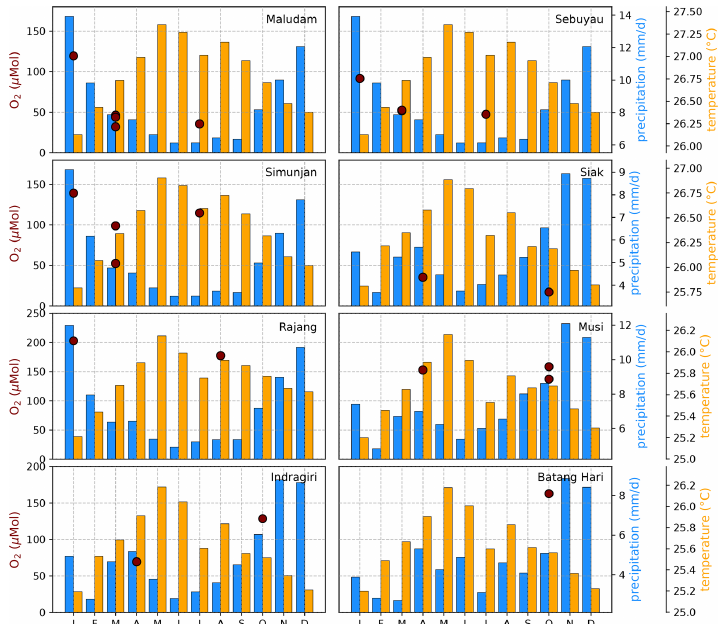
Figure B6. Average O 2 concentrations for individual campaigns compared to monthly temperature (Natawa, 2018a; Yasutomi et al., 2011) and precipitation (Natawa, 2018b; Yatagai et al., 2020) data (2005–2015 average) at the location of the respective river. Each panel represents one